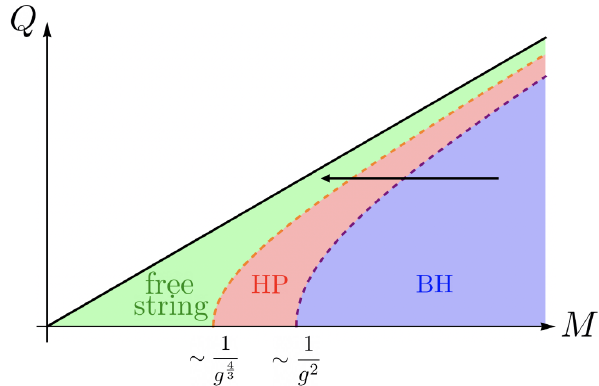
Figure 11 . The approach to extremality for a charged black hole with momentum and winding charges follows the behavior of the seed uncharged black hole as we decrease its mass. Here we display the behavior for d = 3 , or D = 4 . In other dimensions, such as d = 5 we expect to have a first order transition to the free string picture as we approach extremality, see figure